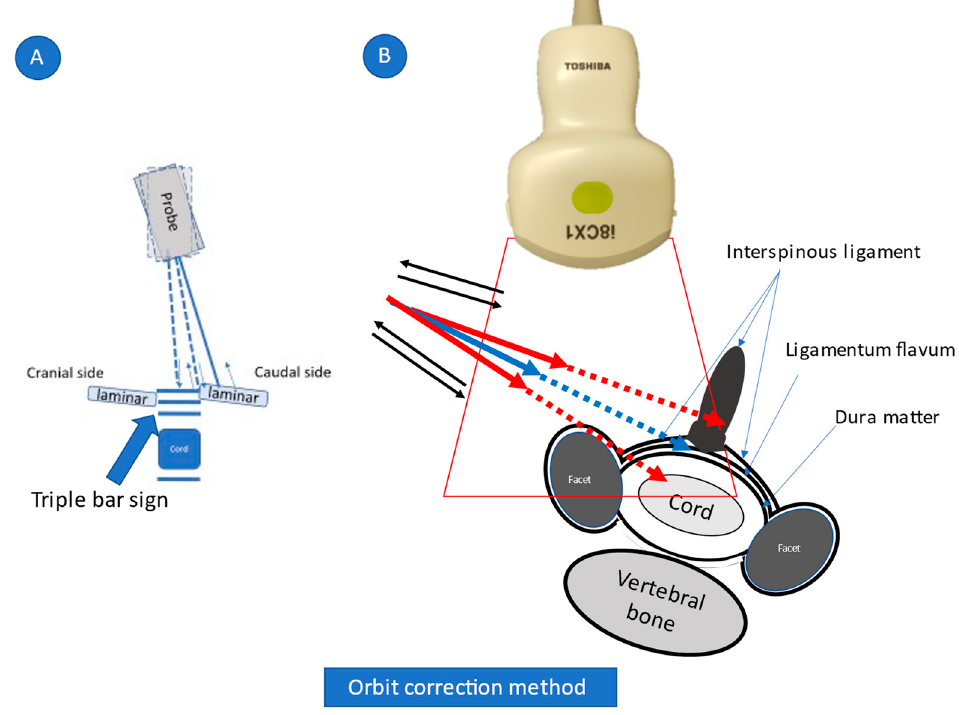
Figure 3. Orbit correction method.